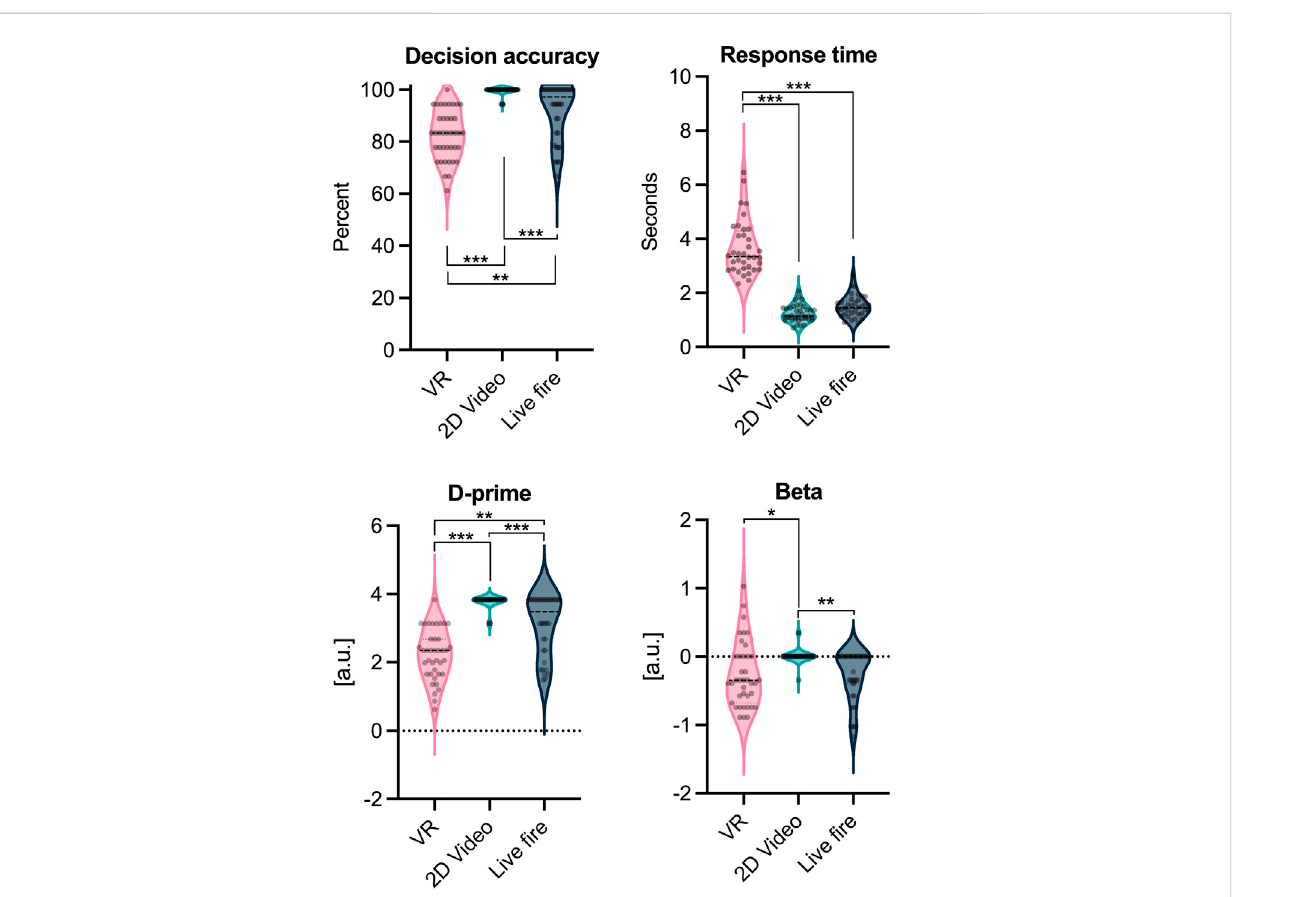
FIGURE 6 Violin plots comparing decision-making variables between the three simulation conditions. * p < .05, ** p < .01, *** p < .001, a.u. = arbitrary units.